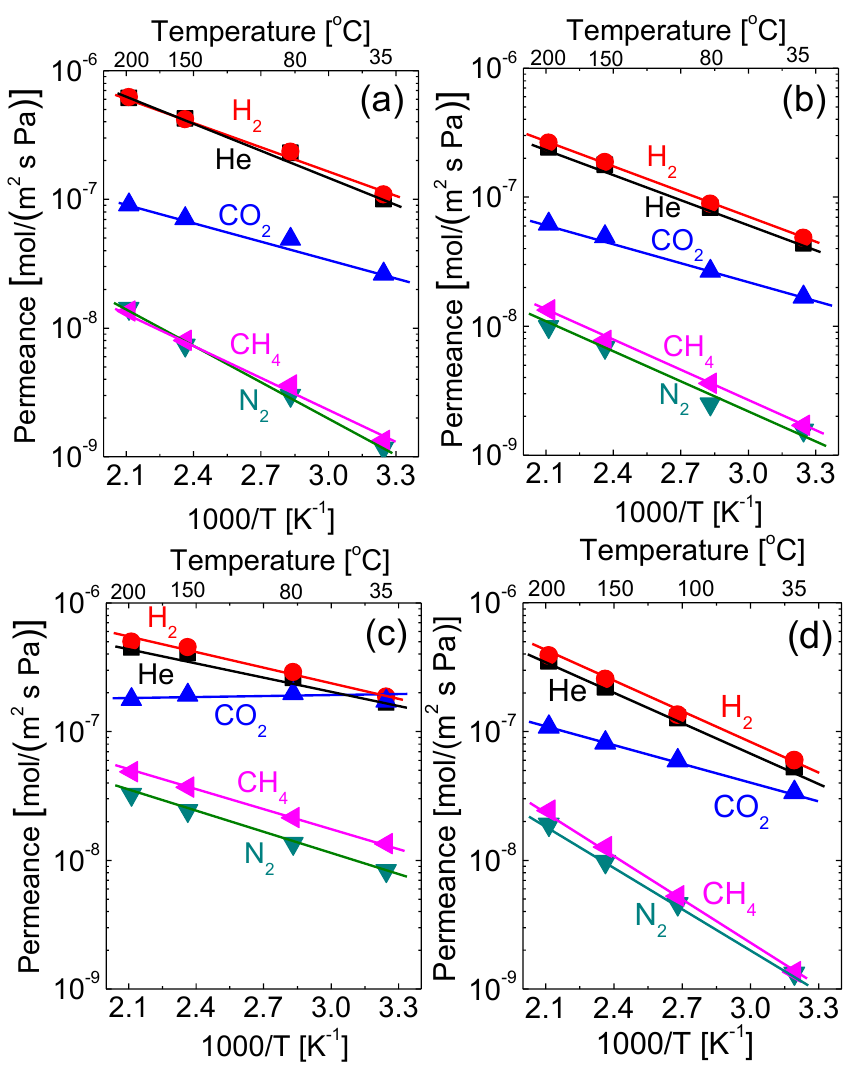
Figure 14. Temperature dependence of gas permeance for amine-functionalized organosilica membranes: ( a ) PA-Si, ( b ) SA-Si, ( c ) TA-Si, and ( d ) BTPP. Results were reorganized from refs. [21,22].